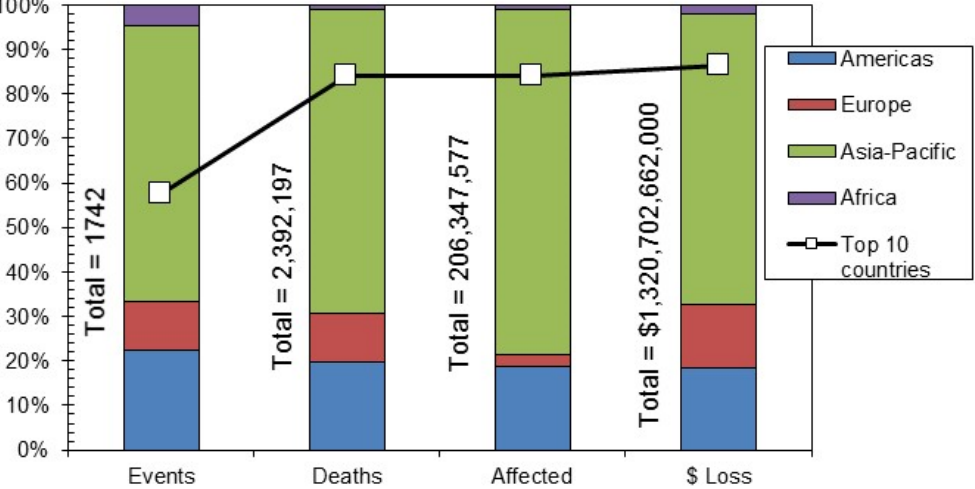
Figure 2. Distribution of events, deaths, persons affected, and economic loss due to geophysical disasters across the globe during the period 1900–2020 AD (Data Source: [57]).